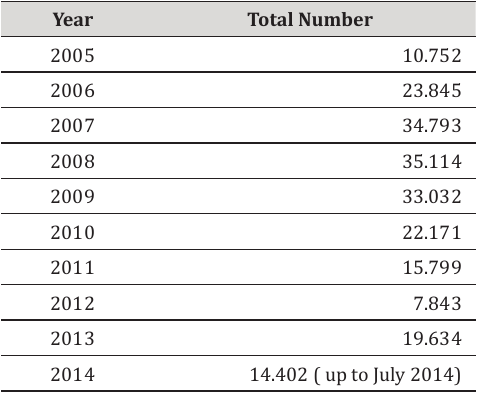
the table below table 5: troubled Indonesian overseas workers in tanjung pinang